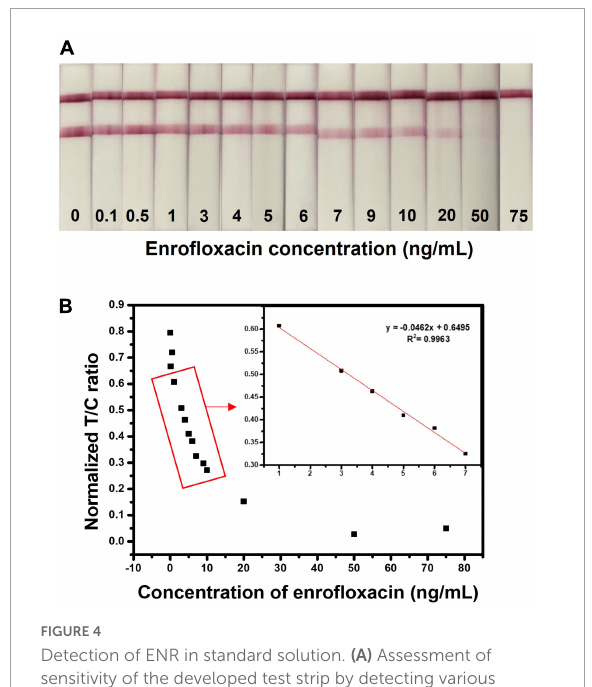
FIGURE4 Detection of ENR in standard solution. (A) Assessment of sensitivity of the developed test strip by detecting various concentrations of ENR (0, 0.1, 0.5, 1, 3, 4, 5, 6, 7, 9, 10, 20, 50, and 75 ng/ml) standard solutions in the borate buffer. (B) Relationship between normalized T/C ratio and the ENR concentration. The normalized T/C ratio was calculated by removing the background value of test strips by the ImageJ